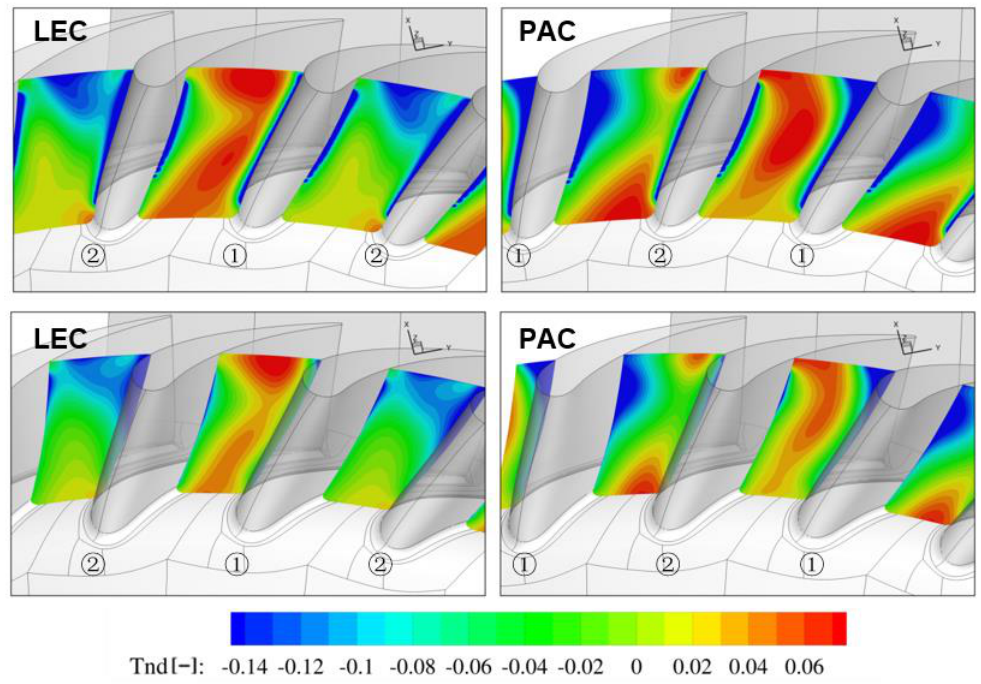
Figure 14. Non-dimensional temperature inside the NGV passage.